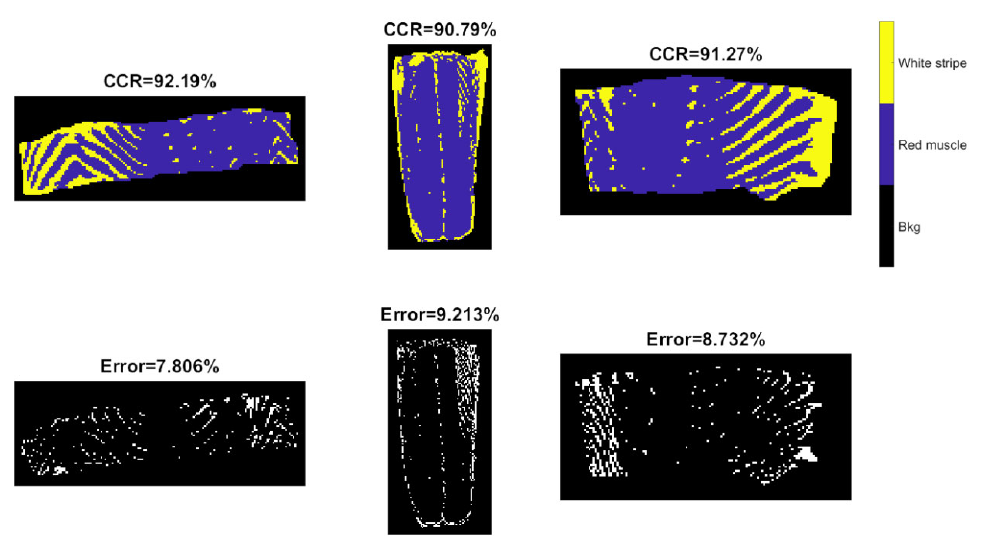
Figure 14. Classification and misclassification maps for validation (the left image) and test sets (the middle and right images) obtained by the 3 ‐ D CNN model built from EPO pre ‐ treated